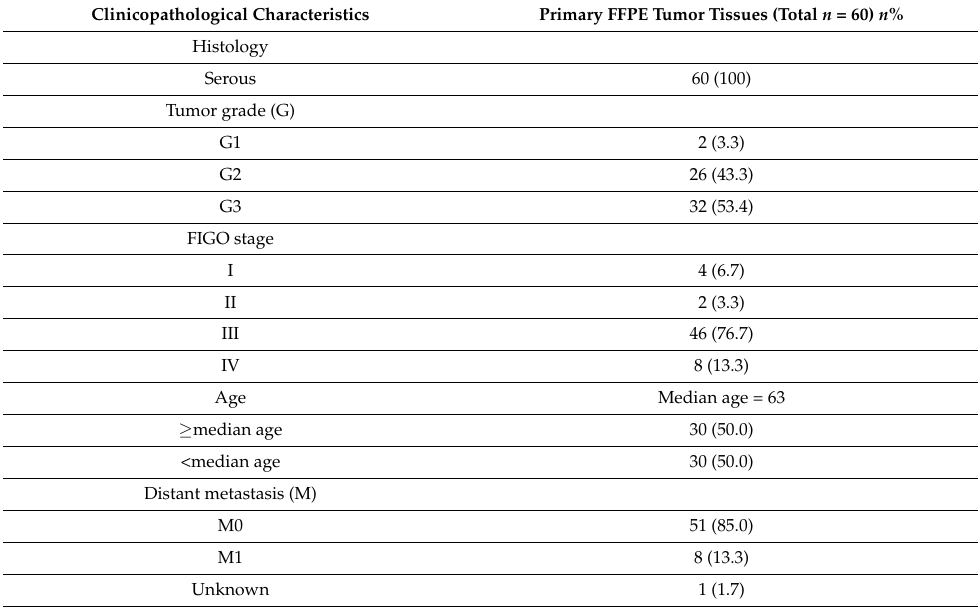
Table 1. Clinicopathological characteristics of the advanced HGSOC patients.